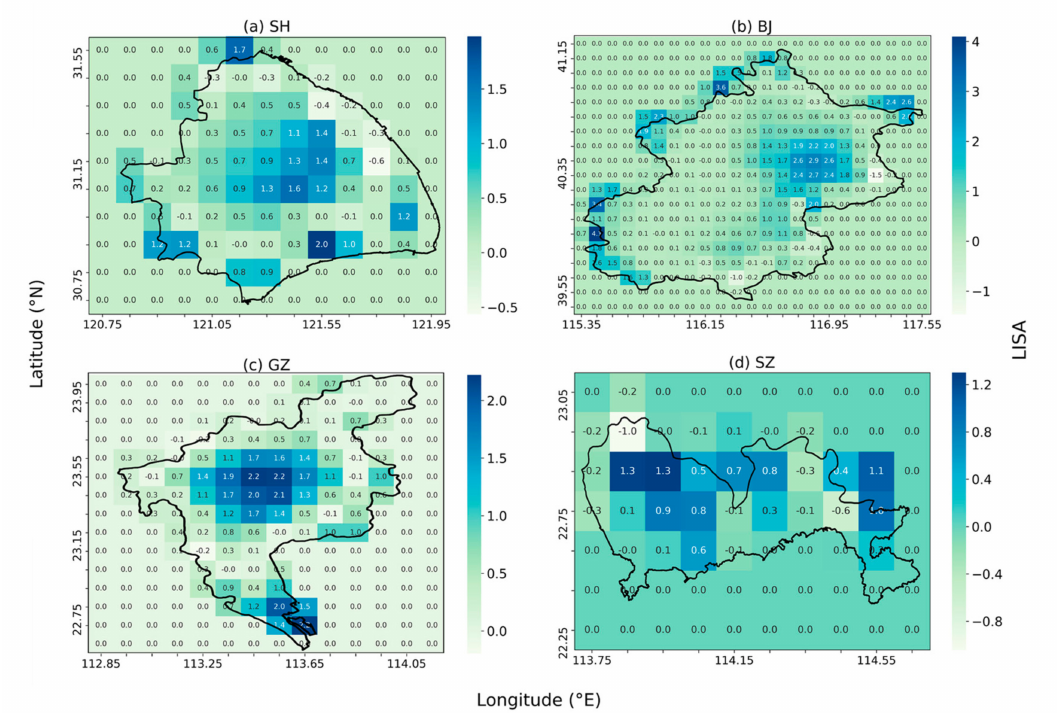
Figure 9. Analysis of locations of clusters (results in LISA) for four study cities. (Gridded cells which outside the scope of study areas are covered by 0 values, zero represents randomness in spatial autocorrelation